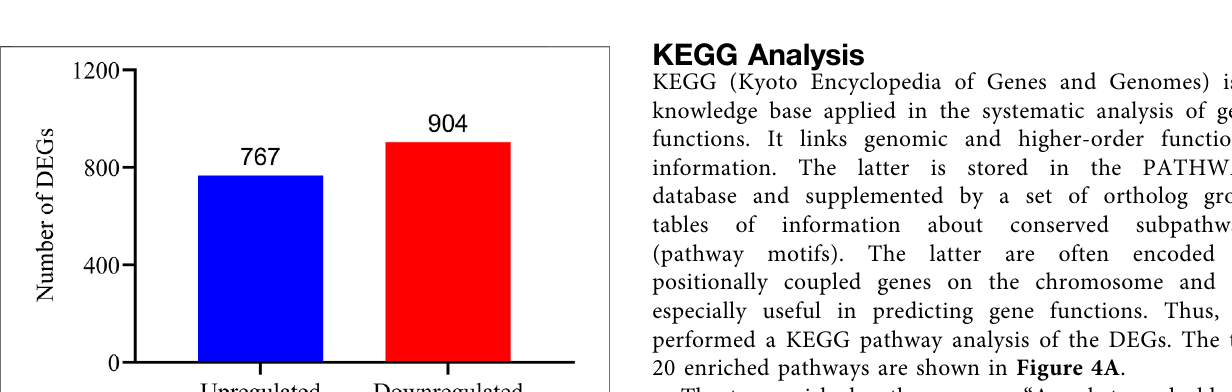
Frontiers in Physiology |